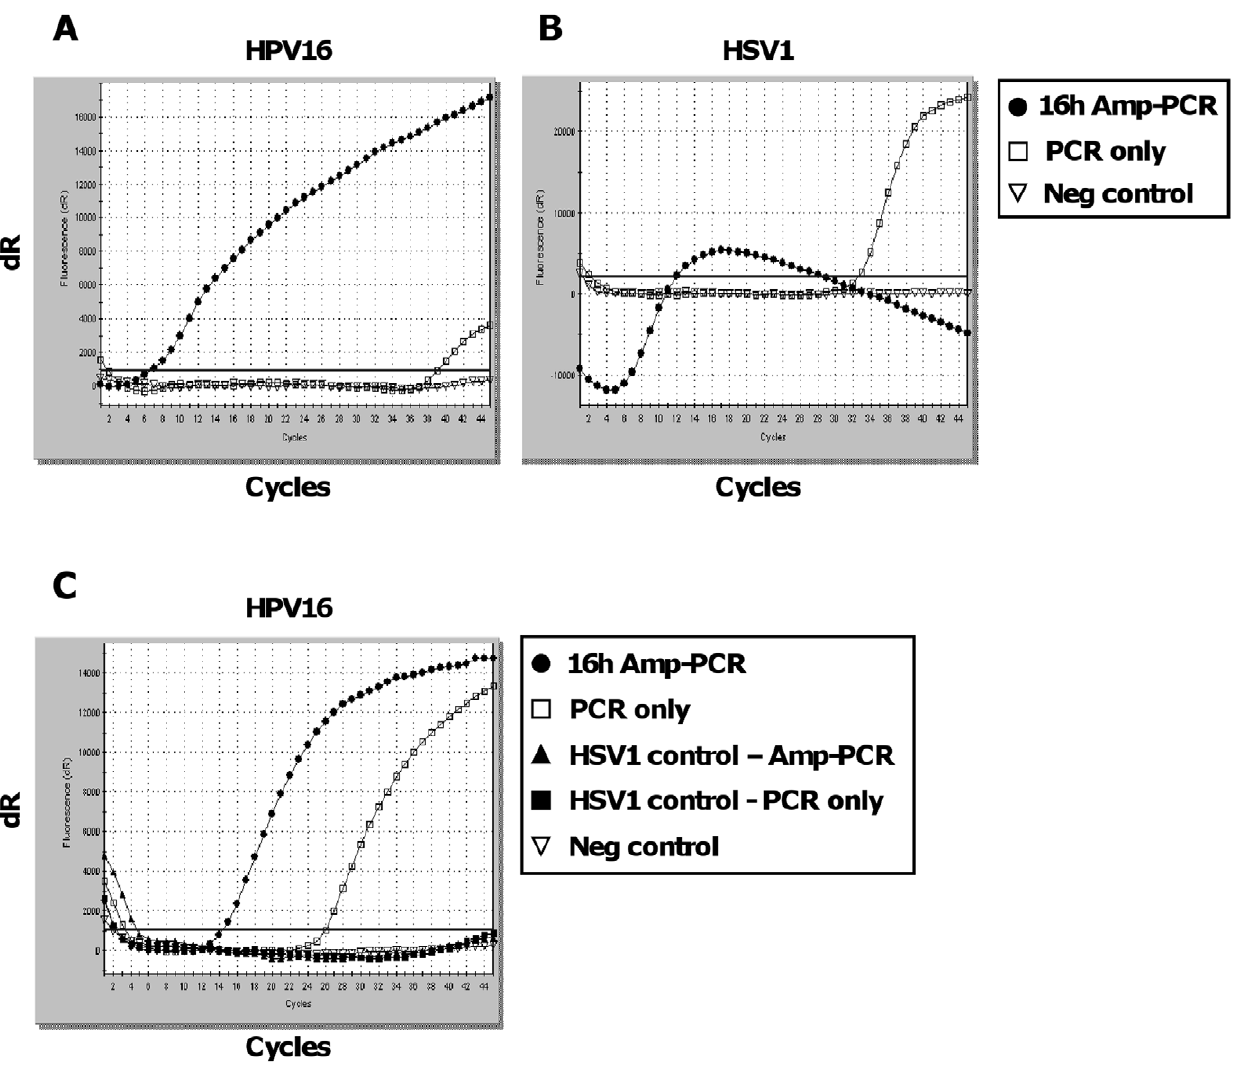
Figure 4. Testing Amp-PCR on other clinical samples. Amp-PCR was performed on a circular and a linear dsDNA virus purified from clinical samples, combining 16 hours of Repli-g with virus-specific real-time PCR. (A) Amp-PCR on purified HPV16. Negative control is water. (B) Amp-PCR on purified HSV1 (showing a typical wave-shaped curve reported for over-saturated PCR-reactions). Negative control is water. (C) HSV1-positive sample used as a negative control in a HPV16-specific Amp-PCR.